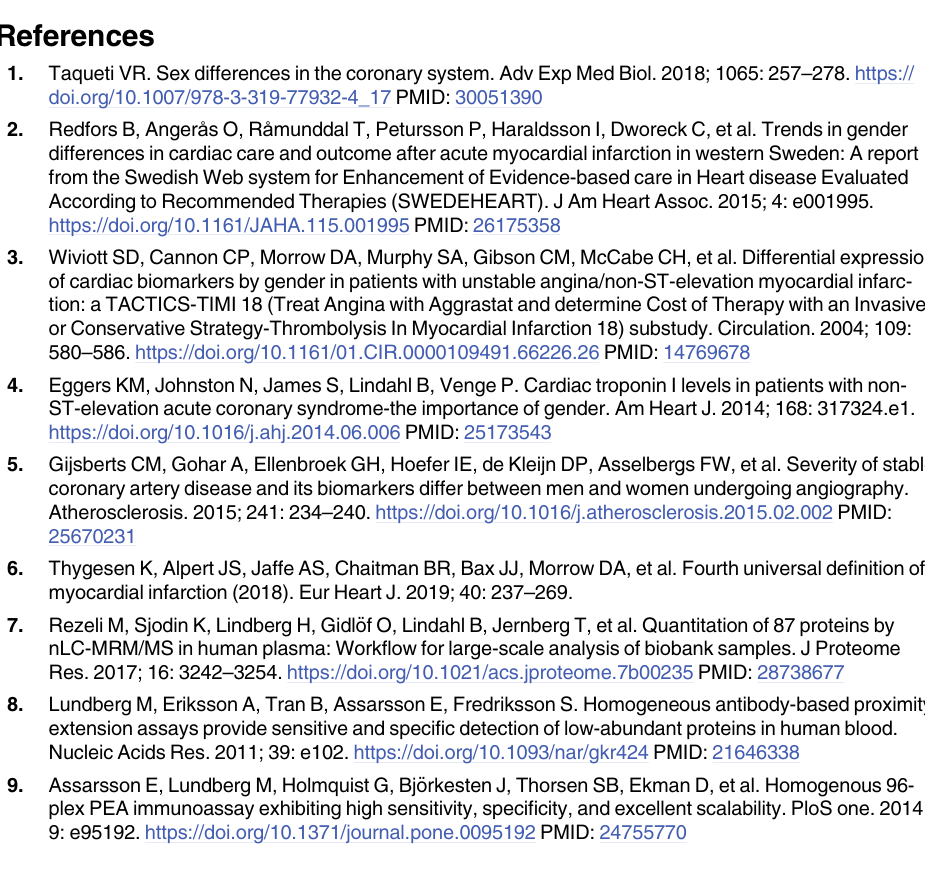
S7 Table. Cardiac troponin assays used during the study